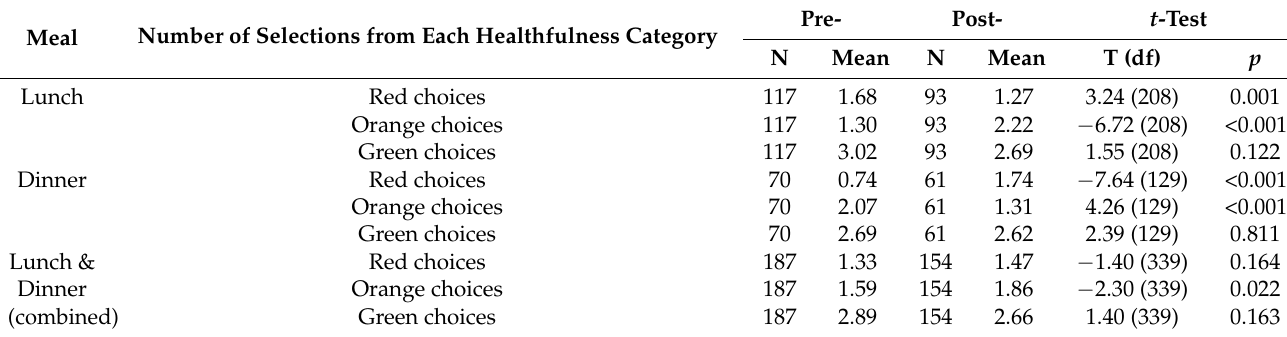
Table 5. Selections from each healthfulness category: pre- and post-communication (pre n = 190; post n = 159 meal photos) 1 . Meal Number of Selections from Each Healthfulness Category